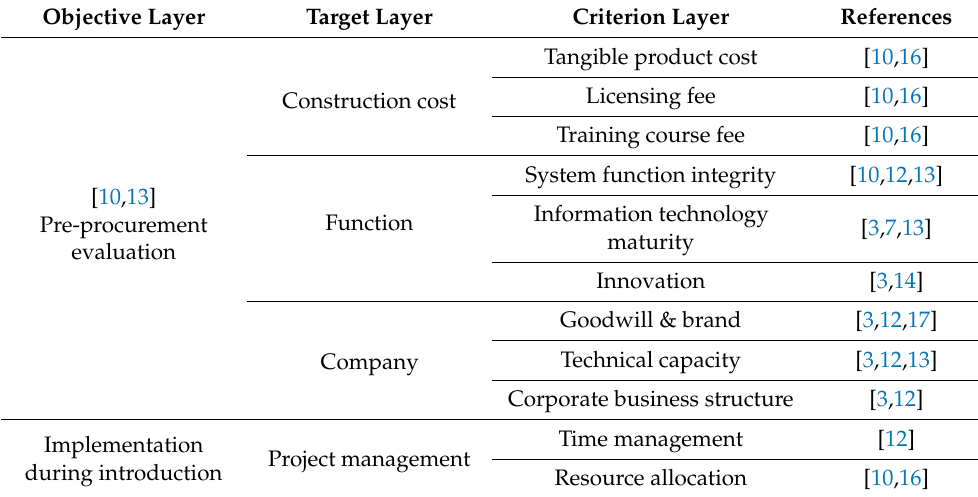
Table 2. The main factor hierarchy and literature for companies to introduce